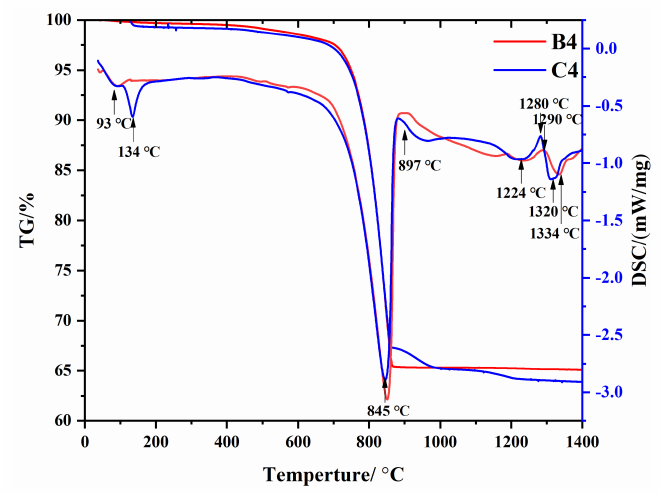
Figure 4. TG-DSC curves of B4 and